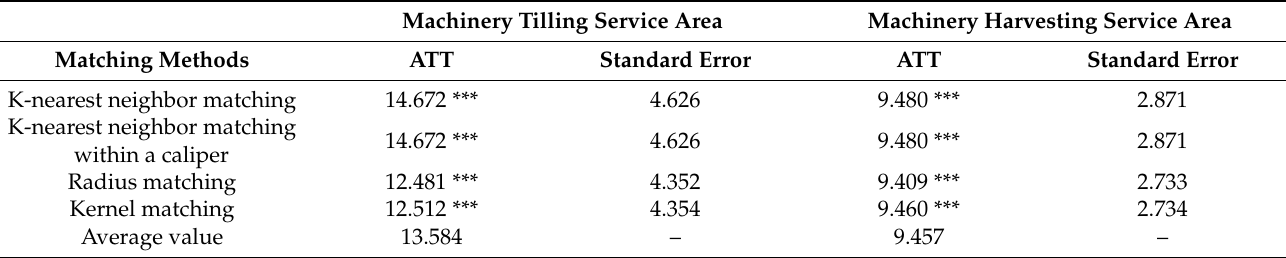
Table 4. Results of PSM (agricultural machinery operation service area).